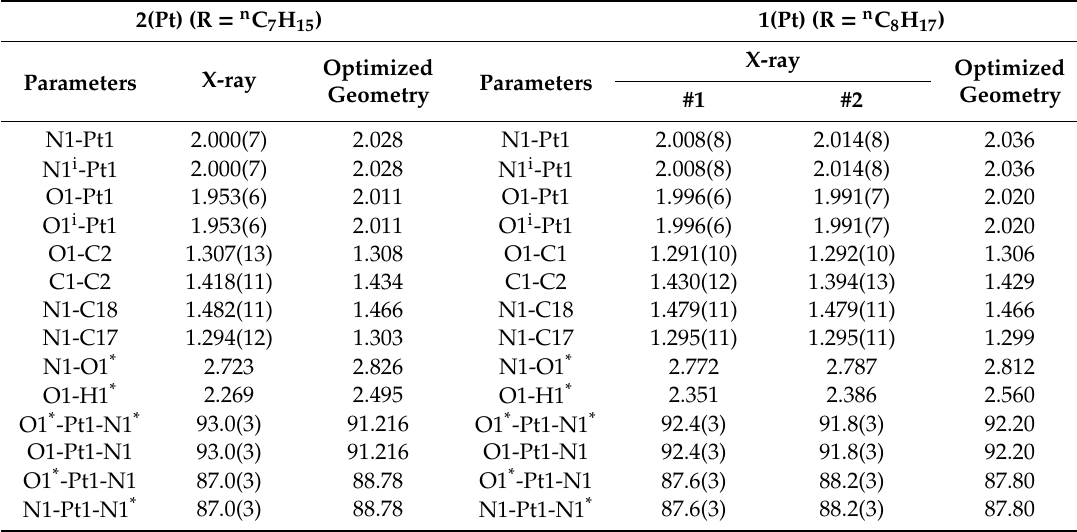
Table 1. Comparison of the selected geometric parameters from the X-ray di ff raction analysis and DFT calculations (R = CH 3 ) for the complexes 2(Pt) and